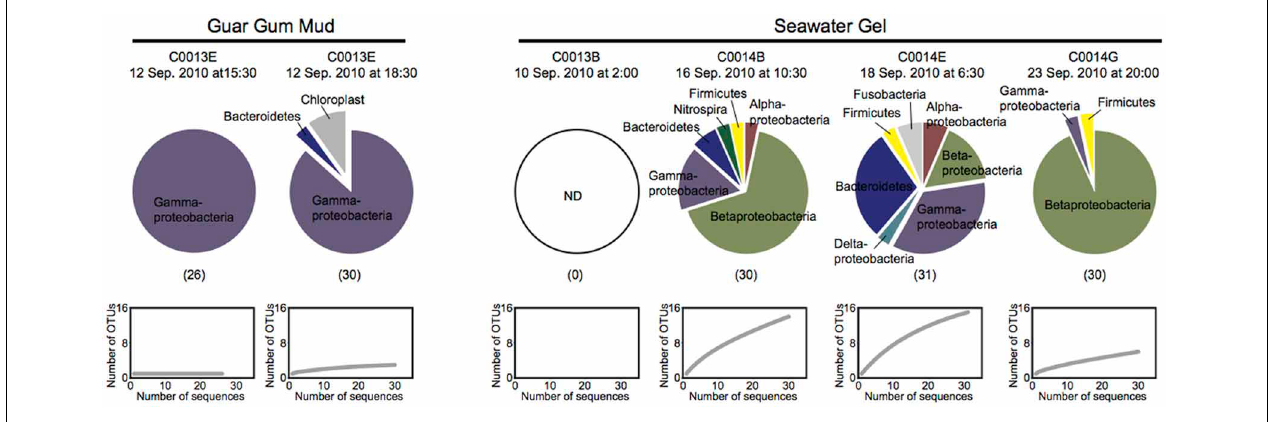
FIGURE 2 | Microbial 16S rRNA gene phylotype compositions and rarefaction curves for the clone libraries for the guar gum mud and the seawater gel mud, which were used as drilling mud fluids during the